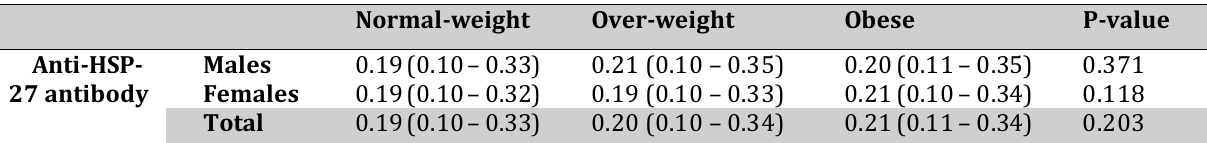
Table 2. Association between subgroups of BMI and serum anti-HSP-27 antibody titers in MASHAD study